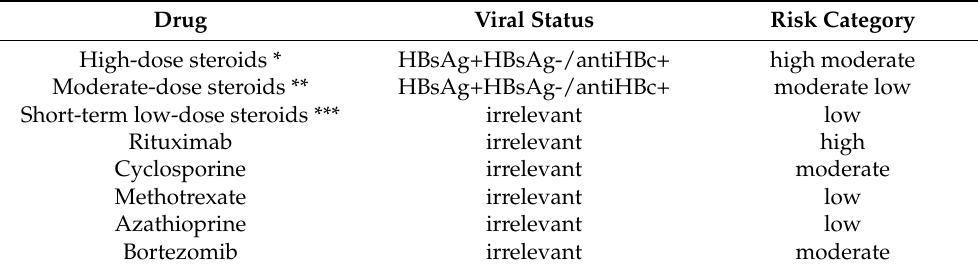
Table 2. Risk of hepatitis B virus (HBV) reactivation for different AIHA treatments according to viral